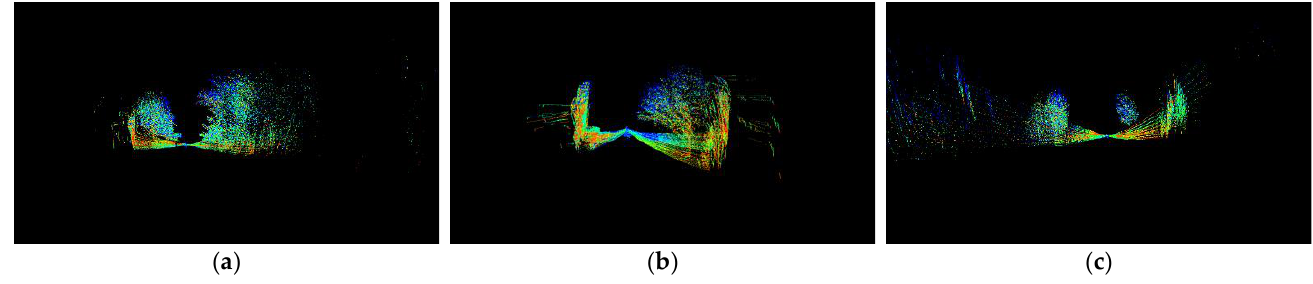
Figure 7. Point cloud image scene 3: President-Park-Outside-S16 ( a ) Picture 1, ( b ) Picture 2, ( c ) Picture